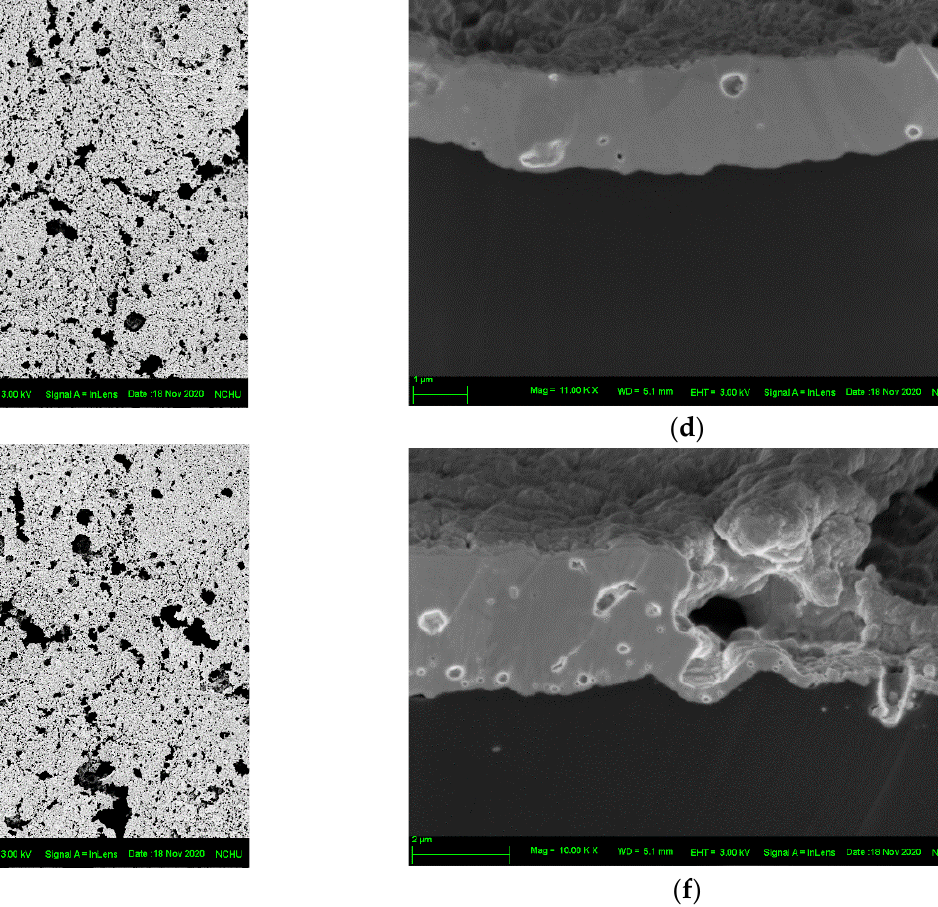
Figure 8. Top view and cross-sectioned images of the sintered structure on O 2 plasma-treated PI substrate subjected to different bending cycles: ( a , b ) undeformed, ( c , d ) 50% of cycles to failure, ( e , f ) cycles to failure.